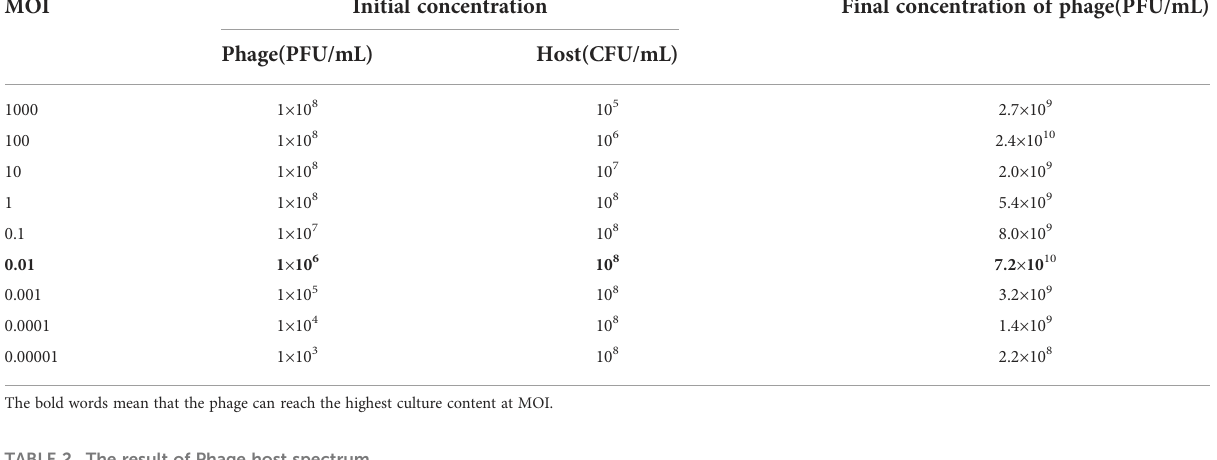
TABLE 2 The result of Phage host spectrum. bacteria